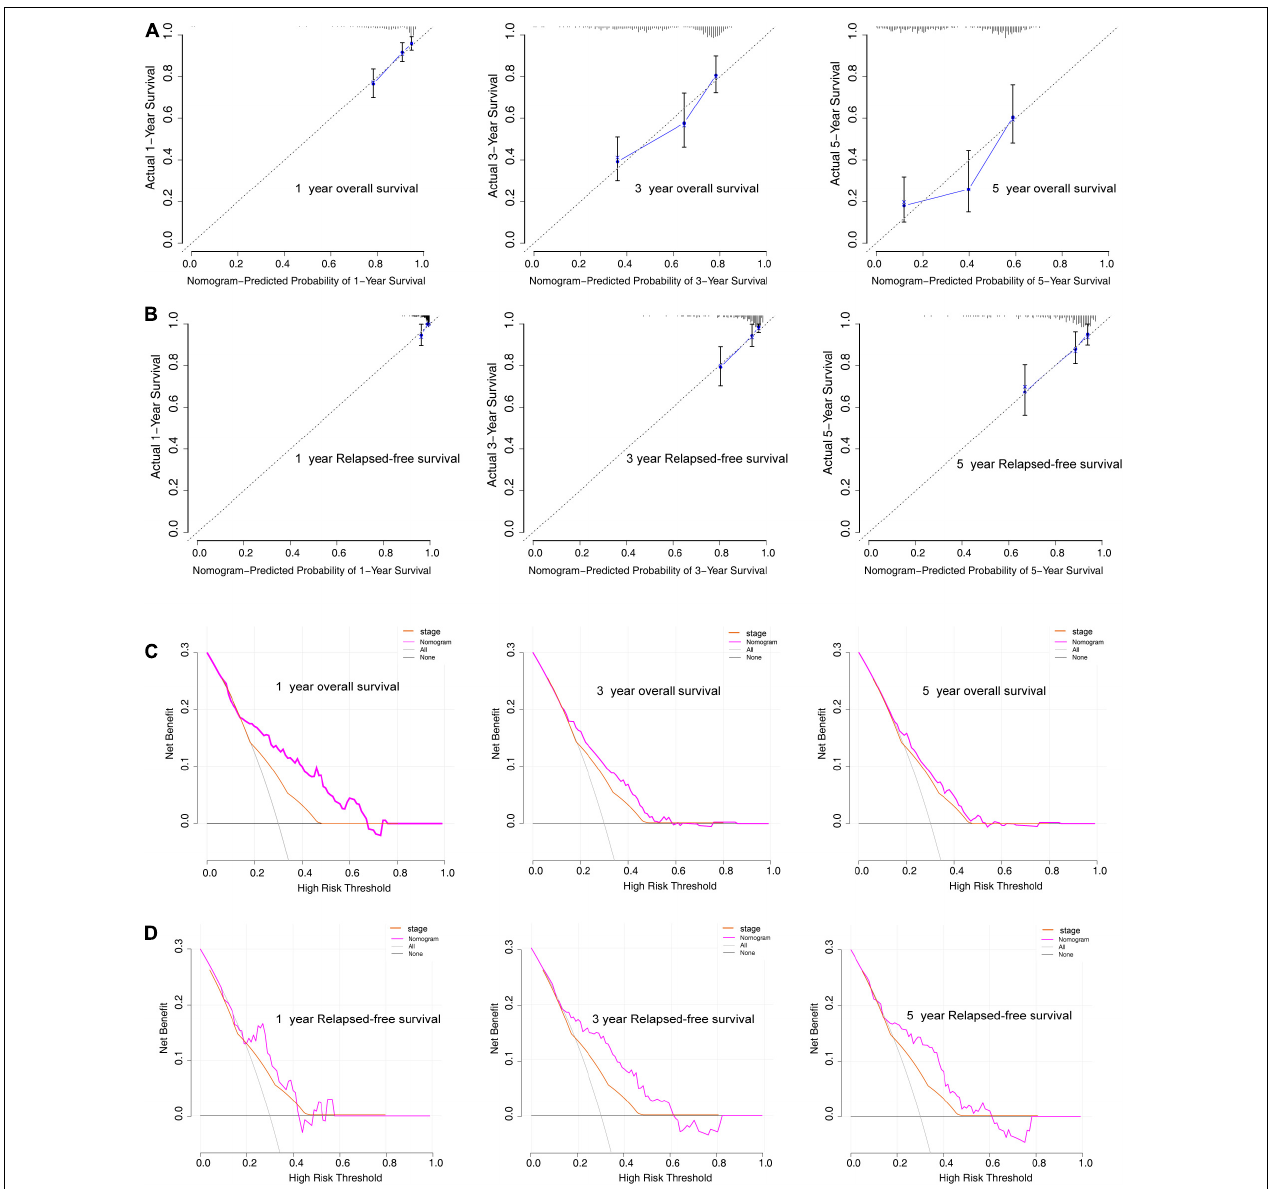
FIGURE 11 | Model discrimination and performance in the training set. (A,B) Calibration plot examining predictive accuracy for 1-, 3-, and 5-year overall survival and relapse-free survival rate. (C,D) Decision curve analysis of the nomogram for 1-, 3-, and 5-year overall survival and relapse-free survival rate in LUAD